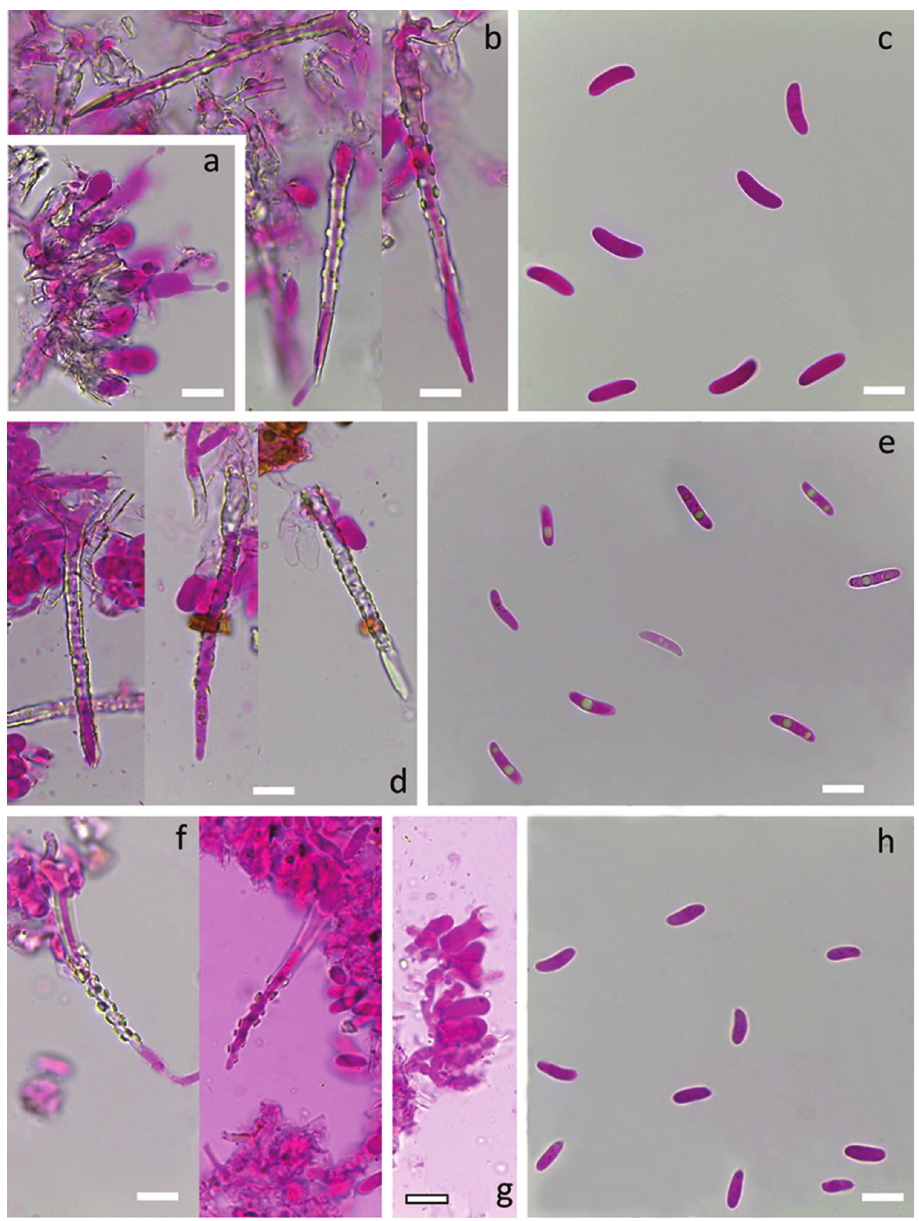
Figure 6. Species of Subulicystidium with long cylindric basidiospores. Subulicystidium grandisporum (LR 29162 in O:F 506781): a hymenium with rich crystalline encrustation b cystidia c basidiospores. Subulicystidium obtusisporum (FR: W213-3-I): d cystidia e basidiospores. Subulicystidium rarocrystallinum (LR 15483 in O:F 918488, holotype): f cystidia g hymenium h basidiospores. All preparations done in 3% aqueous solution of potassium hydroxide (KOH) mixed with 1% aqueous solution of Phloxine. All scale bars equal 10